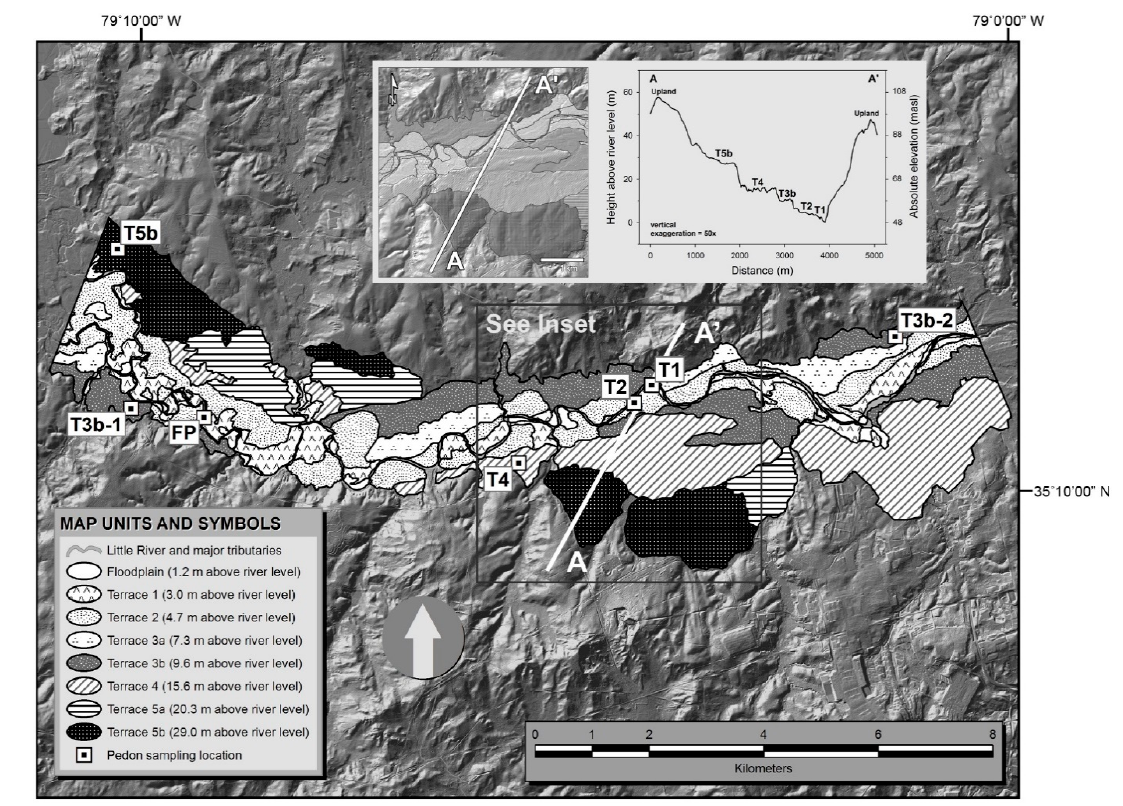
Figure 2. Geomorphic map of the Little River valley, modified from Figure 2 of Suther et al. [29] and Figure 2 of Suther and Leigh [33]. The inset depicts topographic cross-section A-A’ in the vicinity of the Terrace 1 and 2 (T1 and T2) sampling locations. Map units in the inset are shown at 60 percent transparency so that hillshading is visible for terrace surfaces. Vertical exaggeration of shaded relief in both the main and inset maps is 3X. Reprinted from Geomorphology, 351, Suther, B.E., Leigh,